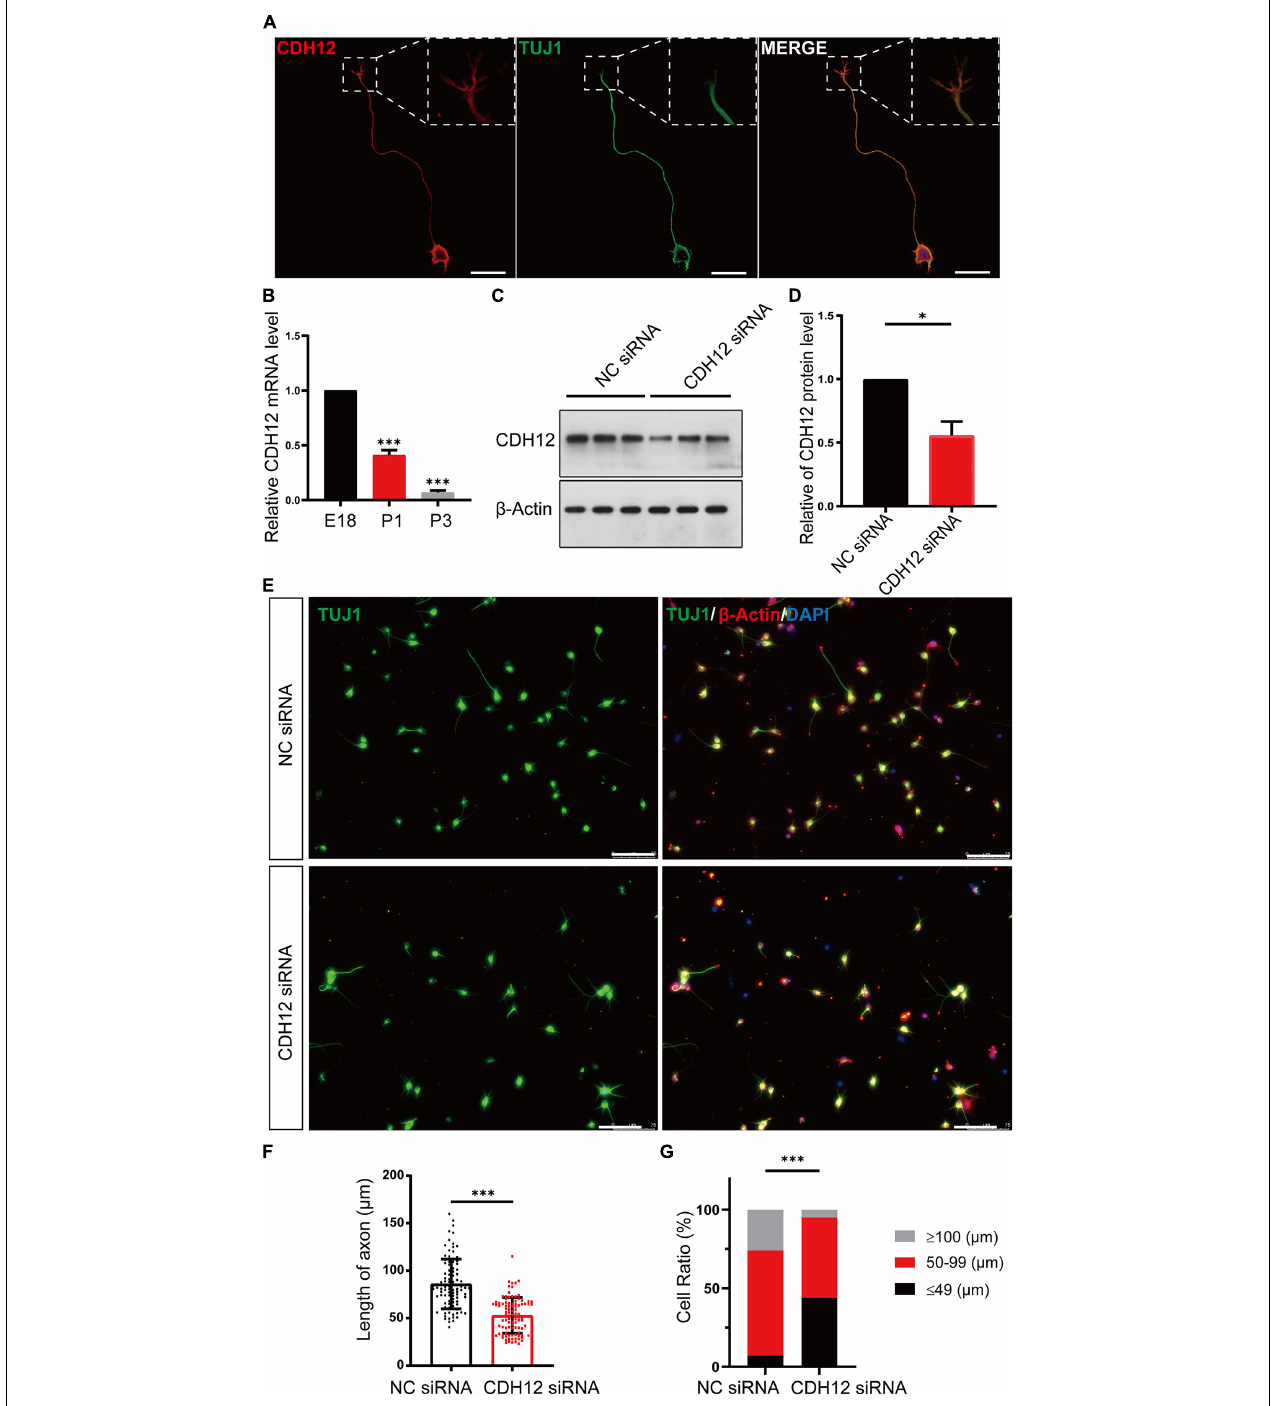
FIGURE 1 | CDH12 knockdown decreased neurite outgrowth in E18 neurons. (A) Representative images of immunofluorescence staining showing the expression of CDH12 in the cell membrane of the cell body, axon, and growth cone. The white dashed box shows an enlarged view of the growth cone. The scale bar represents 25 µ m. (B) The mRNA level of CDH12 in cortical neurons decreased gradually with development (E18, P1, P3) as detected using real-time PCR. The level of CDH12 mRNA in E18 neurons was normalized as 1. The data were shown as mean ± SE, n = 3, ∗∗∗ P < 0.001. Western blotting (C) and statistical (D) results showing the effectiveness of small interfering RNA in knocking down CDH12 expression. β -actin was used as a loading control. The value of CDH12/ β -actin in NC siRNA treatment was normalized as 1. The data were shown as mean ± SE, n = 3, ∗ P < 0.05. (E,F) CDH12 knockdown significantly decreased axon growth in E18 neurons after CDH12 siRNA treatment for 36 h. The scale bar represents 75 µ m. The data were shown as mean ± SD, n = 96, ∗∗∗ P < 0.001. (G) The ratio of neuronal development (with different axonal lengths) was affected by CDH12 knockdown. n = 100, ∗∗∗ P < 0.001 (two-way ANOVA).